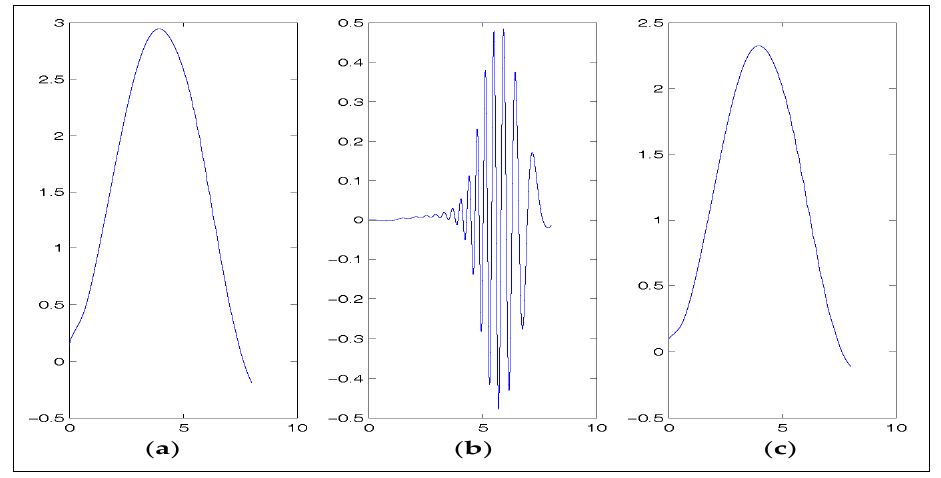
Figure 11. The development of c d ( t ) , c l ( t ) , and ∆ p ( t ) (from to ( a – c ), respectively) for level-3 mesh with (cid:52) t = 0.00125, viscosity ν = 10 − 3 , χ = 0.01 and N =